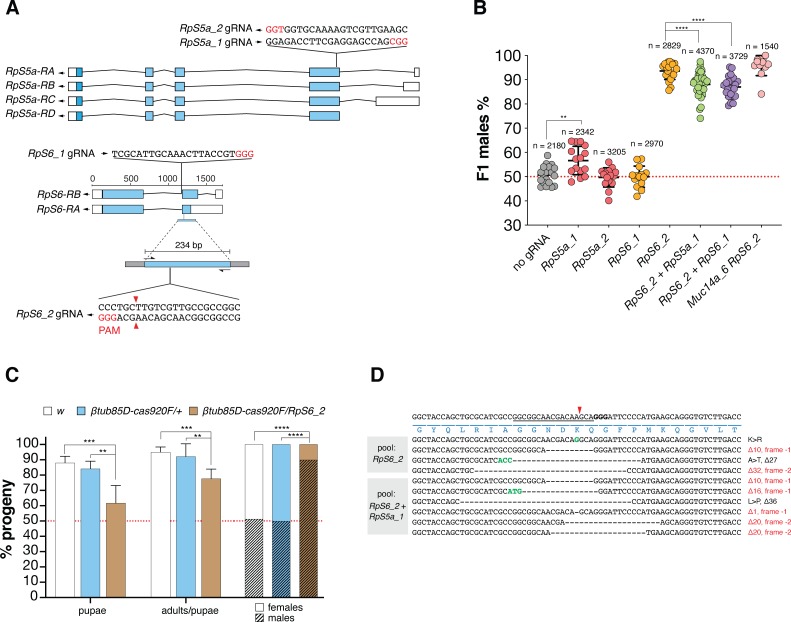
(A) gRNA target sites within presumptive haploinsufficient genes on the X-chromosome. Schematic representation of RpS5a and RpS6 gene organization. Both genes encode for a small ribosomal subunit protein (RpS). As illustrated in the figure, the RpS5a gRNAs, RpS5a_1 and _2, map in the fourth exon shared by all four transcripts of the gene and the RpS6 gRNAs, RpS6_1 and 2, map in the third exon of two transcripts in the corresponding gene. The figure shows the 234 bp fragment (with Illumina Sequence adapters on both sides as grey boxes) surrounding the RpS6_2 gRNA target site that was used for amplicon sequencing. Blue boxes indicate coding sequences, white boxes indicate UTR regions and PAMs are indicated in red. (B) Efficiency of single gRNAs or combinations of gRNAs for X-poisoning. Shown is the frequency of males in the progeny from βtub85D-cas9 males combined with four gRNA lines and crossed to wild type w females. Individual gRNAs, RpS5a_1 or RpS5a _2 (red), and RpS6_1 or RpS6_2 (orange) are compared to double gRNA arrays co-expressing RpS6_2 + RpS5a_1 (green) or RpS6_2 + RpS6_1 (purple) as well as a combination of both RpS6_2 and Muc14a_6 transgenes (pink). As a control, crosses from βtub85D-cas9/+ (no gRNA, grey) fathers are shown. Each dot represents the percentage of F1 males from a cross between one male and three females. n is the number of individuals (males + females) in the F1 progeny. Black bars show means ± SD for at least ten independent single crosses. Statistical significance was calculated with a t test assuming unequal variance. **p < 0.01, ***p< 0.001 and ****p< 0.0001. All crossing data can be found in S7 Table. (C) Developmental survival analysis of the F1 progeny of RpS6_2/βtub85D-cas9, w or βtub85D-cas9/+ males crossed to w females. Left columns: embryos to pupae survival rate; central columns: pupae to adults survival rate and right columns: fraction of males and females in adults. Bars indicate means ± SD for at least ten independent single crosses. Statistical significance was calculated with a t test assuming unequal variance. **p < 0.01, ***p< 0.001 and ****p< 0.0001. All crossing data can be found in S8 Table. (D) CRISPR induced target site mutations within the RpS6 gene analysed by pooled amplicon sequencing of surviving female progeny. On top, the wild type DNA sequence spanning the RpS6_2 gRNA target site in the RpS6 ribosomal gene is shown with the gRNA binding position (underline), the cut site (red arrowhead), the PAM (bold nucleotides) as well as the encoded amino acids (blue). Target site variants identified in pools of F1 females from RpS6_2/βtub85D-cas9 fathers or RpS6_2 RpS5a_1/βtub85D-cas9 fathers are shown below. Dashed lines correspond to nucleotide deletions, green coloured bases represent insertions. Predicted amino-acid substitutions (>) are indicated to the right.